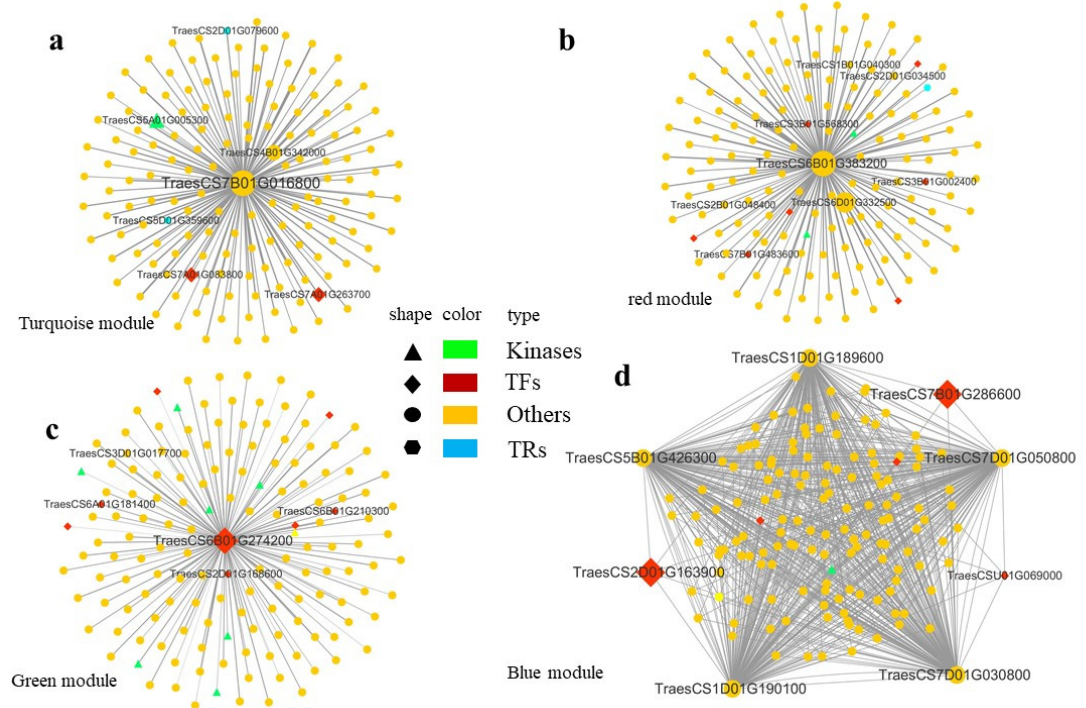
Figure 6. WGCNA was used to establish co-expression networks of DEGs in four signi fi cant mod- ules. ( a ) Turquoise module network. ( b ) Red module network. ( c ) Green module network. ( d ) Blue module network.